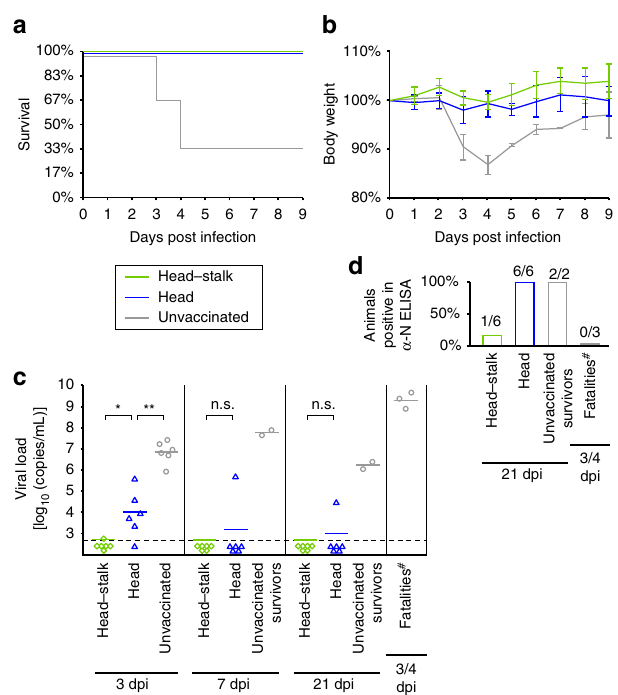
Fig. 4 Immunization with the SBV head – stalk fragment protects IFNAR − / − mice from viremia. a , b Survival curves ( a ) and relative body weight development ( b ) of vaccinated and unvaccinated mice over the fi rst 9 days post infection ( n = 6 per group). The immunization antigens were head – stalk (aa 465 – 874) and head (aa 465 – 702). Weights are given as mean percentage ± s.d. c Viral genome loads at 3, 7, and 21 days post infection (dpi) or on the day when an unvaccinated animal had to be euthanized (fatalities). Genome equivalent concentrations were determined in EDTA – blood samples by S segment-based RT-qPCR. Horizontal bars represent mean values. The dashed line indicates the detection limit (5 × 10 2 copies/mL). Statistical analysis was performed using the Mann – Whitney rank sum test. * P < 0.05; ** P < 0.01; n.s. not signi fi cant ( P > 0.05). d Percentage of animals positive for N protein-speci fi c